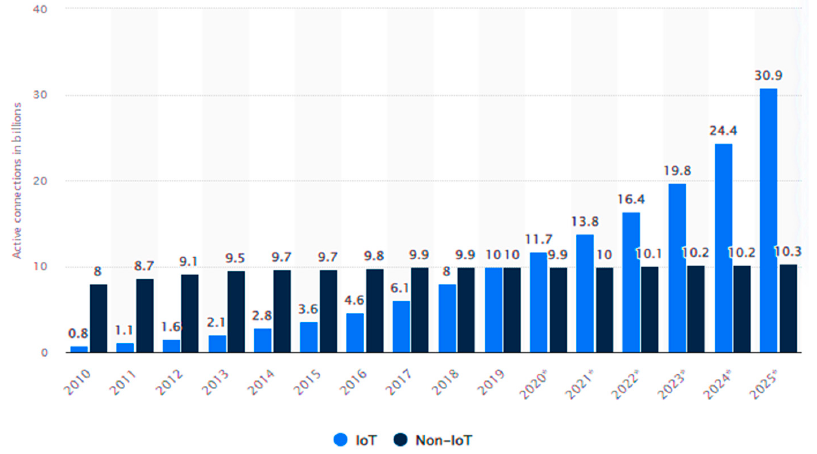
Figure 1. Stats of Active Connections in Billions from 2010 to 2025 on Statista [1]. Reprinted/adapted with permission from Ref. [1]. Copyright 2022, Statista. * shows forecasts.